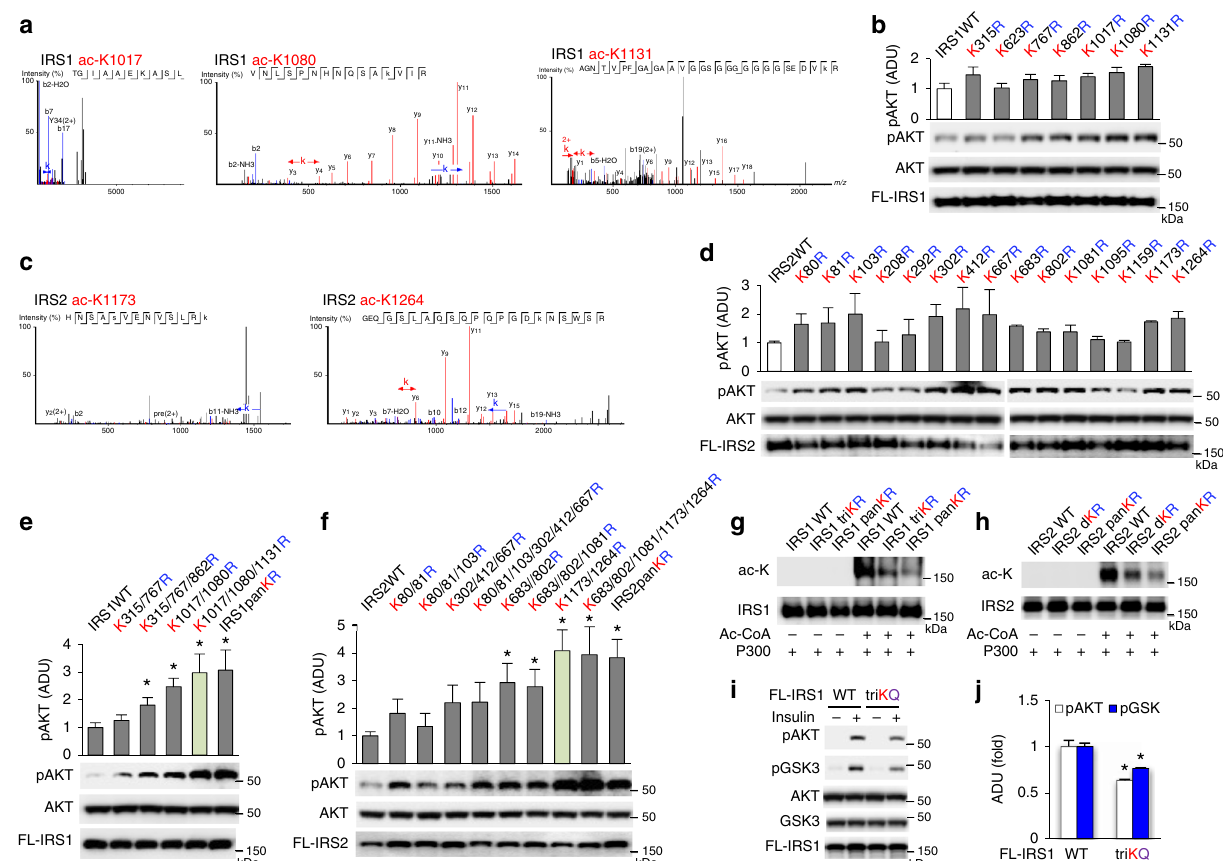
Fig. 7 Identi fi cation and characterization of acetylation sites in IRS1 and 2. a – d To mimic the induction of hepatic P300, we overexpressed P300 along with FLAG-tagged-IRS1 or -IRS2 in Hepa1-6 cells, FLAG-tagged-IRS1 and -IRS2 proteins were puri fi ed and used to map the acetylation sites by mass spectrometry a , c . 2 μ g of plasmids containing IRS1/2-WT or their mutants were transfected into Hepa1-6 cells, cells were harvested 48 h after transfection ( n = 3) b , d . e , f Plasmids of IRS1 or 2 mutants with combined KR mutations and IRS1 or 2 WT plasmid were transfected into Hepa1-6 cells as above ( n = 3). *, P < 0.05, paired sample t -test between groups transfected with WT and mutated IRS plasmids. g , h Puri fi ed Flagged-tagged IRS1/2-WT, and mutant proteins were incubated with 0.2 µ g P300 protein for 1 h at 30 °C in the presence and absence of acetyl-CoA. i , j Forty-eight hours after the transfection of 2 µ g IRS1-WT or – triKQ mutated plasmid, Hepa1-6 cells were treated with 10 nM insulin for 10 min i . Densitometric analysis of pAKT and pGSK3 in cells treated with insulin ( n = 3) j . Data are presented as mean ±